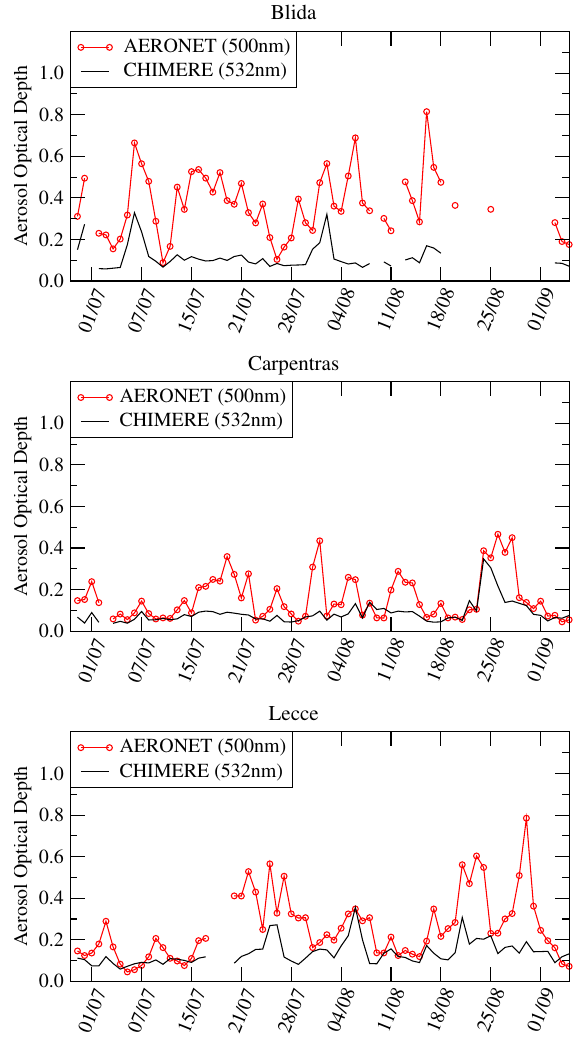
Fig. 9. Temporal evolution of the daily mean AOD (500nm) by AERONET (red line) and the corresponding CHIMERE AOD (at 532nm, black line) at three AERONET sites (Blida, Carpentras, Lecce).